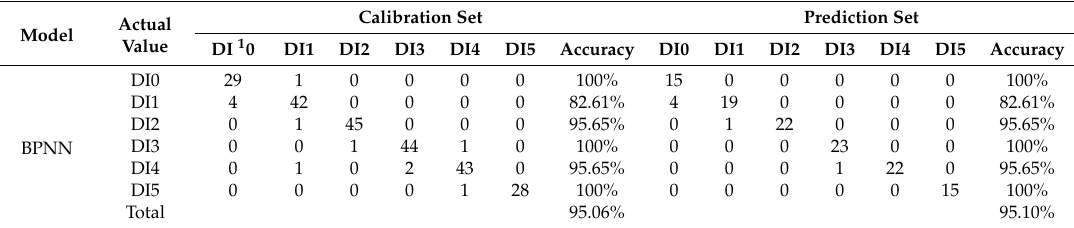
Table 4. Detection accuracy of infestation degrees by the BPNN model based on data